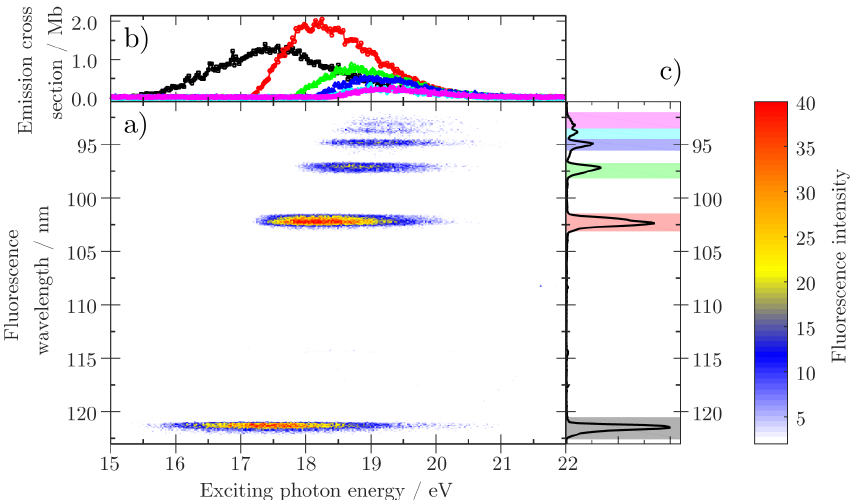
Figure 7. Absolute emission cross section of single transitions of the Lyman series emitted by neutral hydrogen fragments after photodissociation of valence excited water molecules (data taken from [36]). ( a ) 2D colormap of the emission intensity of the Lyman transitions as function of the exciting photon energy; ( b ) absolute emission cross section of the transitions Ly α to Ly (cid:101) as function of the exciting photon energy. For calibration procedure see Ref. [36]; ( c ) emission spectrum integrated over exciting photon energy. Each Lyman transition is colored according to the emission cross section graphs in panel ( b